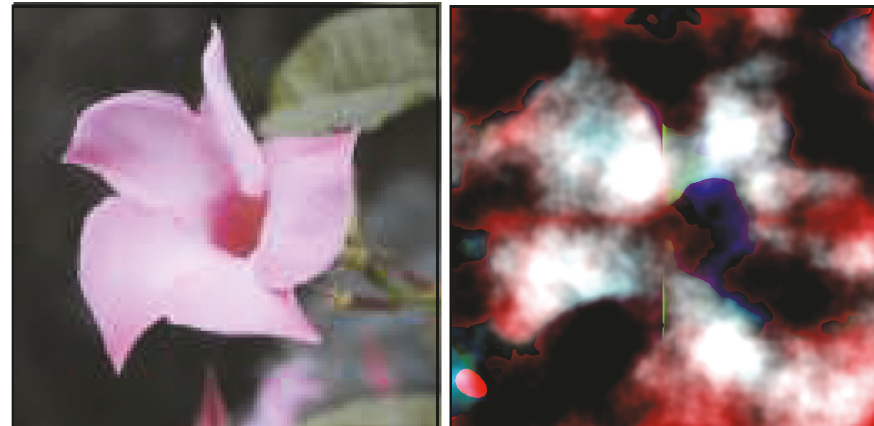
Figure15:Colourexperimenthighlights;flower;noiselanguage.Theleftmostimageshowsthetarget,followedbyanotableevolvedcandidate.